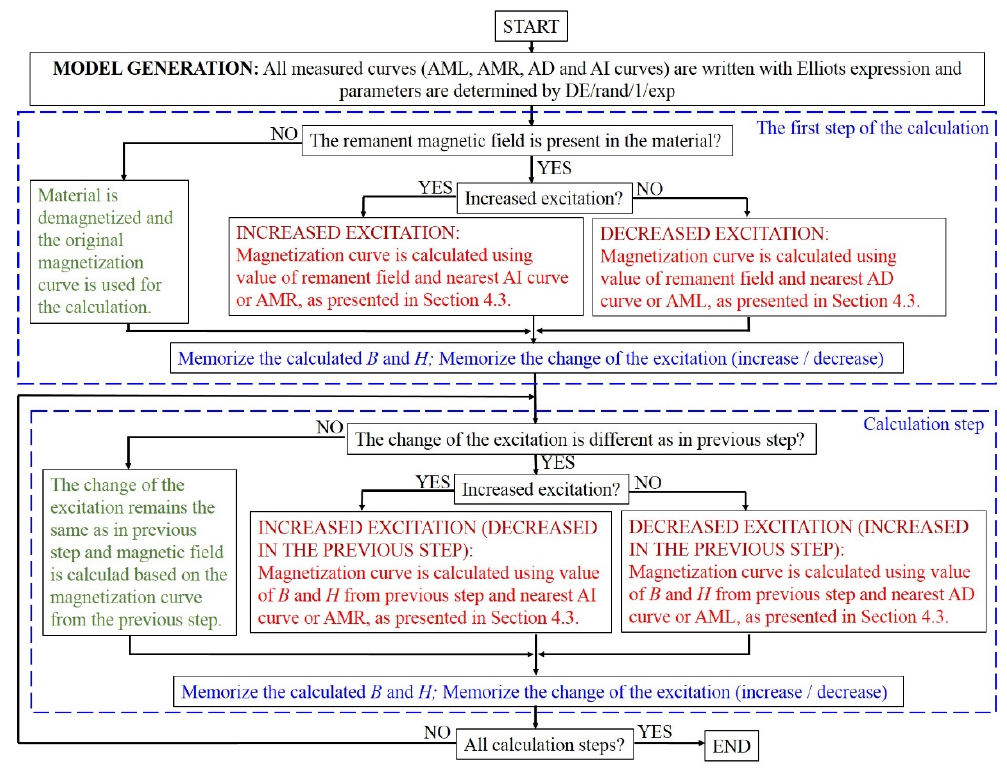
Figure 14. Algorithm presenting the use of the hysteresis model based on Alnico curves.